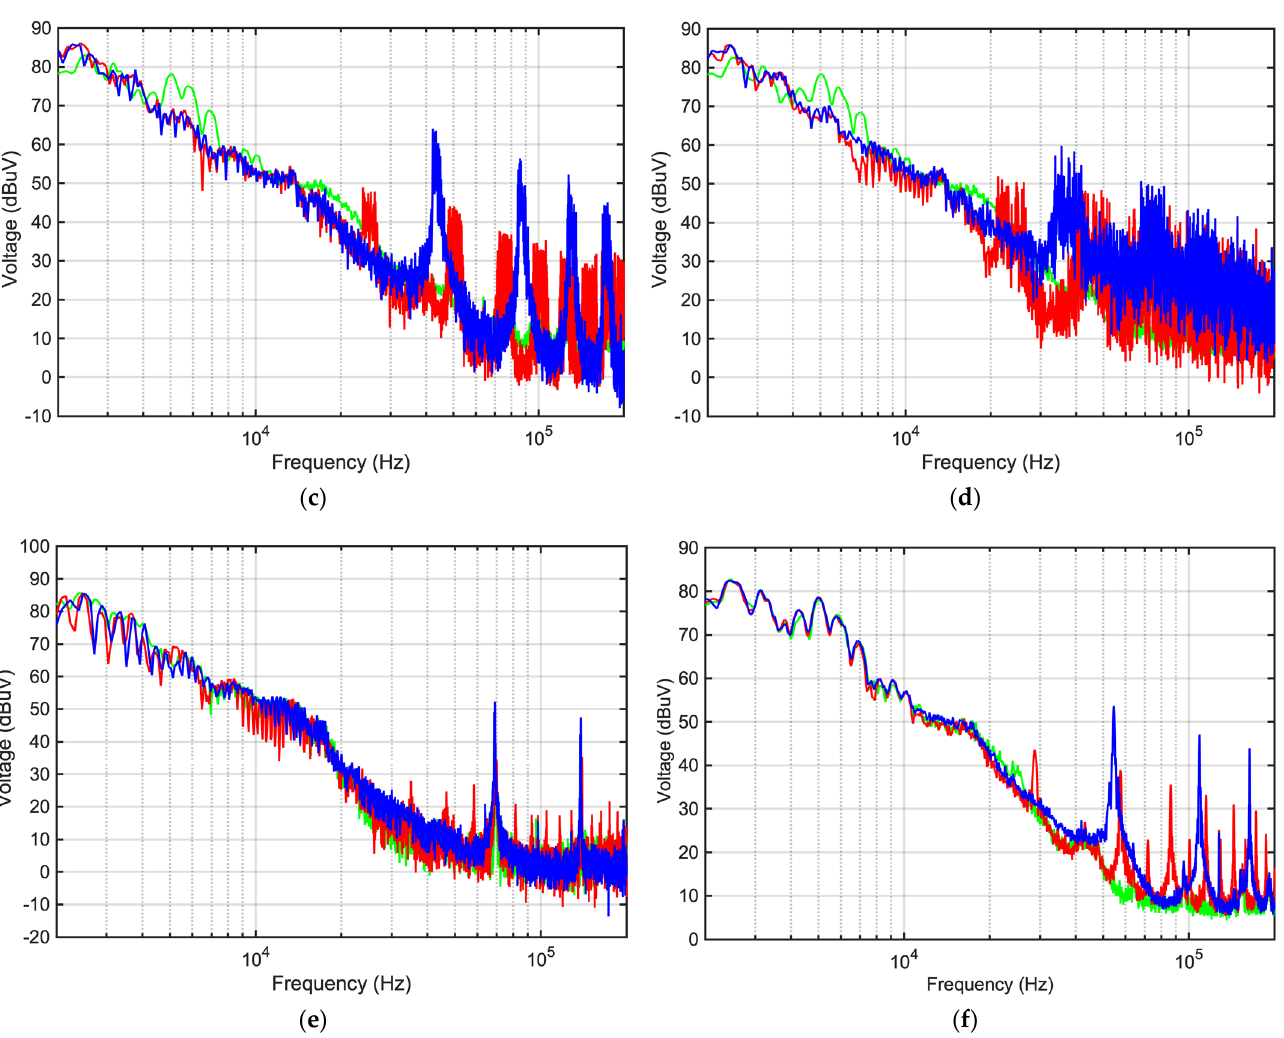
Figure 10. Frequency-domain spectra for no load (green) and 25% (red) and 90% (blue) loads: ( a ) LW, ( b ) LB, ( c ) KT, ( d ) SH, ( e ) BA and ( f ) KA.